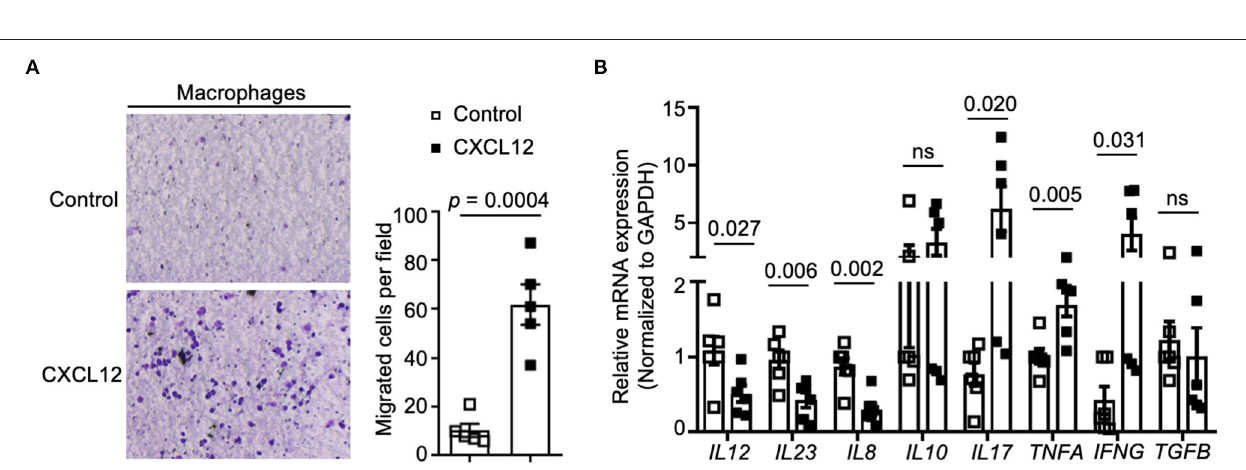
FIGURE 5 | AMD3100 regulated serum levels of cytokines. The levels of IL-12, IL23, TNF- α , IL17A, IL-10, and TGF- β were measured in serum from control and AMD mice in the 0 th , 2 nd , 6, 10, and 18 th weeks post-AOM/DSS treatment by LEGENDplex TM kits ( n ≥ 4). Individual data are shown as Mean ± SD. Statistical analysis was carried out using unpaired t -tests.